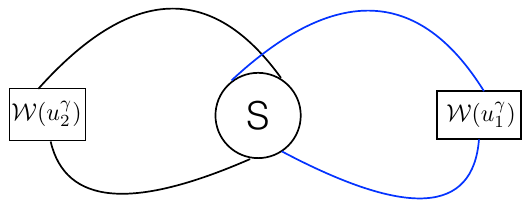
Figure 6 . The matrix part of the two-particle calculation of (2.18). The left ( ) and right H l ( ) hexagon form-factors have only one-particle (fundamental or bound-state) and they are easily H r evaluated. They give a non-zero contribution only for (cid:31) ’s where the dotted indices are conjugate to the undotted indices (1 2) as the one-particle hexagon form-factor is a product of (cid:15) AB . This $ forces the scattering between the particles in the middle hexagon to be diagonal as shown in H m the (cid:12)gure where S means mirror bound state S -matrix. The are weight factors and they act on W the particles corresponding to its